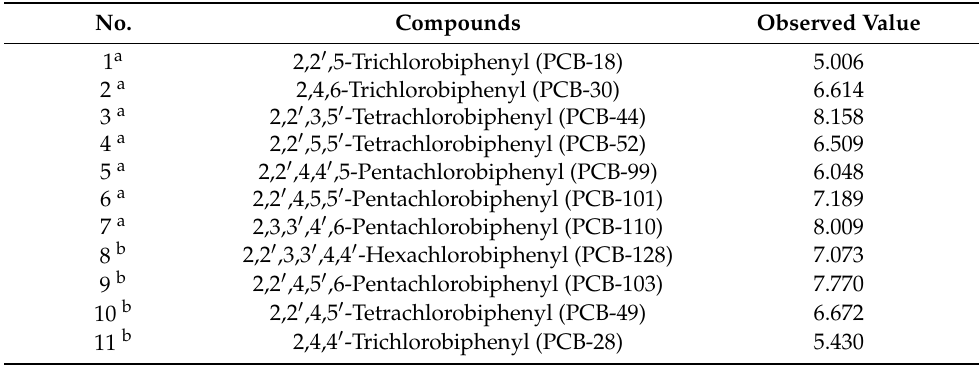
Table 1. Observed pREC 20 values of training set and test set molecules on the CoMSIA model.